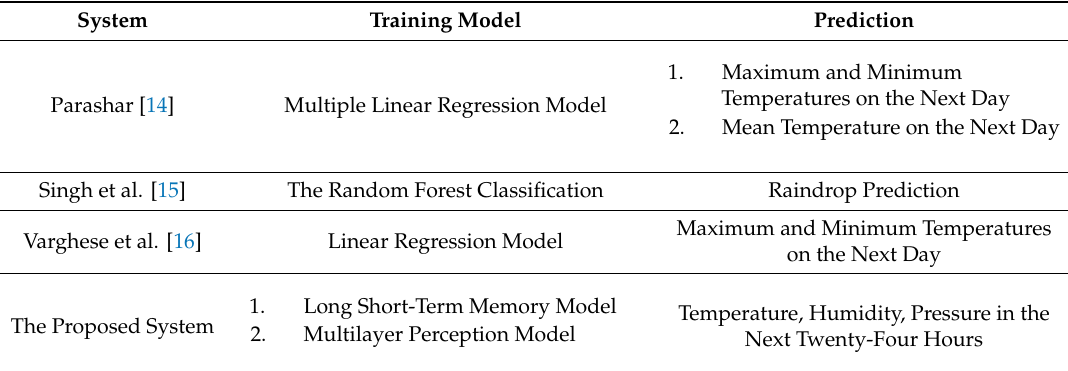
Table 1. Comparison of prediction